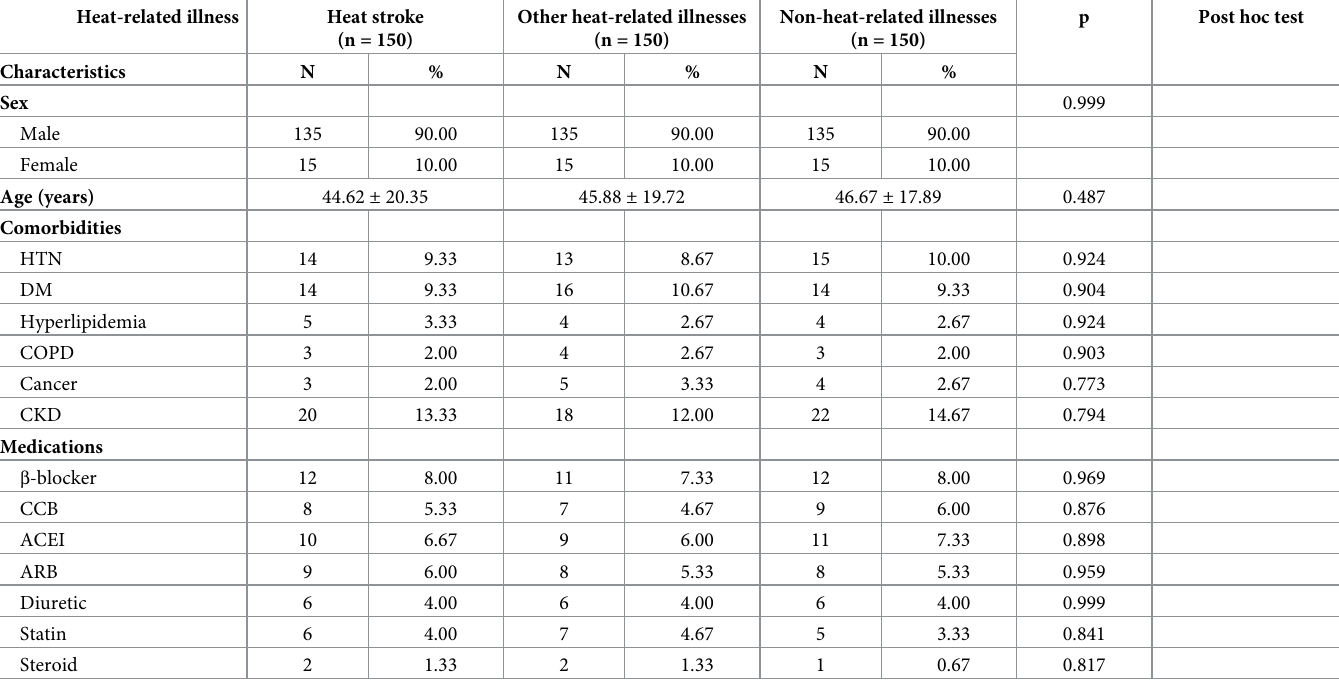
Table 1. Characteristics of the study participants at